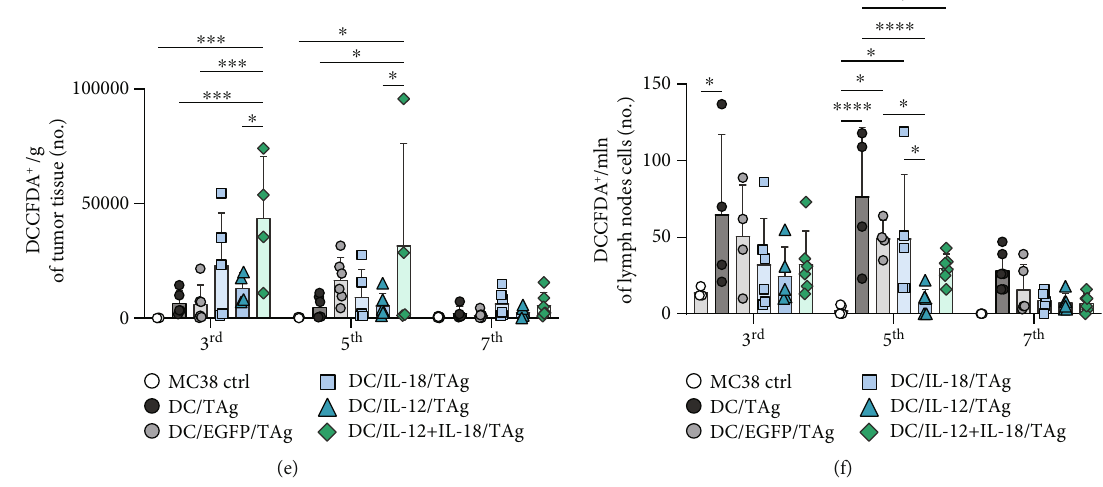
Figure 2: Analysis of the ability of CFDA-labeled DCs to migrate to the tumor-draining lymph nodes or in fi ltrate the tumor nodule of MC38 murine colon carcinoma. (a) Treatment schedule of an in vivo experiment. Mice with established tumors were administered peritumorally (p.t.) with genetically modi fi ed DCs, stimulated with TAg, and then fl uorescently labeled with CFDA-SE. (b) The persistence of DC labeling with CFDA-SE was veri fi ed in in vitro conditions on the 3rd, 5th, and 7th days using fl ow cytometry. tLNs and tumor nodules were collected on the 3rd, 5th, and 7th days after administration of DCs. (c) Percentages of DCs in tumor nodules and tumor-draining lymph nodes. (d) Scheme of the cytometric analysis of CFDA-SE + DCs in collected tissues (here representative data from tumor analysis). After elimination of debris, cell clumps, and dead cells, CD45 + cells were gated, and then among them, CFDA-SE labeled cells were identi fi ed. (e) Mean number + SD of DCs per 1g of tumor weight. (f) Meannumber + SD of DCs per 1 million cells isolated from tumor-draining lymph nodes. The total number of CFDA-SE + DCs in tumor and tLN suspension was measured using counting beads. Results are presented as mean ± SD calculated for 4-6 mice per group. Di ff erences between groups were estimated using the parametric two-way ANOVA followed by Tukey ’ s multiple comparison post hoc test (e, f) ( ∗ p < 0 : 05 , ∗∗ p < 0 : 01 , ∗∗∗ p < 0 : 001 , ∗∗∗∗ p < 0 : 0001